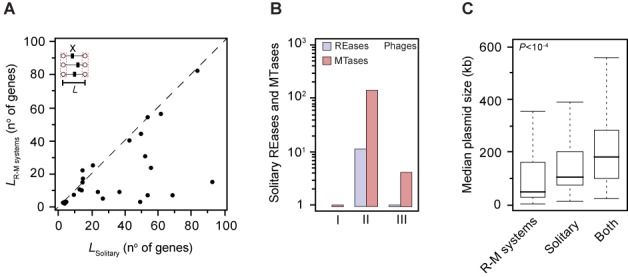
Comparative analysis of complete R-M systems and solitary components. (A) Median size of regions (L, expressed in the number of genes) harboring complete volatile R-M systems versus solitary volatile R-M elements (indicated as X). Stippled line corresponds to the identity. (B) The number of solitary REases and MTases in phages. Over 90% of the total hits were found to correspond to solitary MTases. (C) Median plasmid size (kb) for plasmids containing only complete R-M systems, solitary components or both. Mann–Whitney–Wilcoxon test P value is indicated next to the box plots.